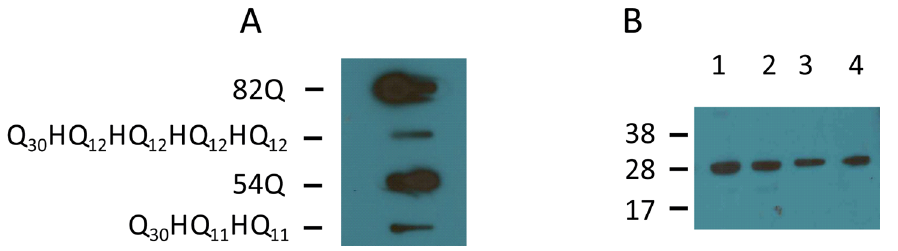
Figure 4. Detection of protein aggregates formed in transfected COS cells by slot blot filter assay. Slot blot filter assay was carried out on the insoluble fraction isolated from transfected COS cells. COS cells were transfected with ataxinCT constructs expressing polyQ repeats with and without His interruptions. Cell pellets obtained after lysis were treated with DNAse I, boiled in 2% SDS and filtered through a cellulose acetate membrane. Aggregated protein retained on the membrane was detected with anti-ataxin-1 antibodies. ( A ) Proteins retained from uninterrupted (82Q; 54Q) and interrupted (Q30HQ12HQ12HQ12HQ12; Q30HQ11HQ11) polyQ expressing cells. Results were consistent across three separate experiments. ( B ) Supernatants obtained after cell lysis from each of the above samples were subjected to immunoprecipitation using anti GFP antibodies and the precipitates were subjected to western blot analysis using anti-GFP antibodies. Lane 1, uninterrupted Q82; lane2, interrupted 82Q; lane 3, uninterrupted 54Q; lane 4, interrupted 54Q. Molecular weight markers are indicated on the left.